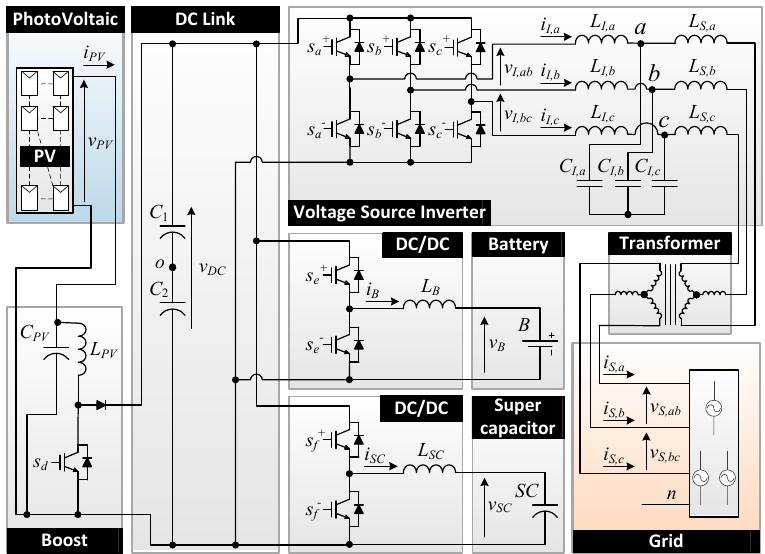
Figure 2. Topology of the photovoltaic inverter with hybrid energy storage system proposed.